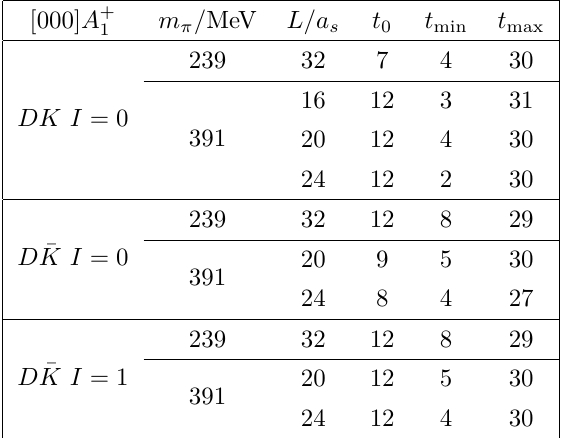
Table 10 . The maximum overall fitting ranges and t 0 values used for the fits presented in fig- ures 20, 21 and